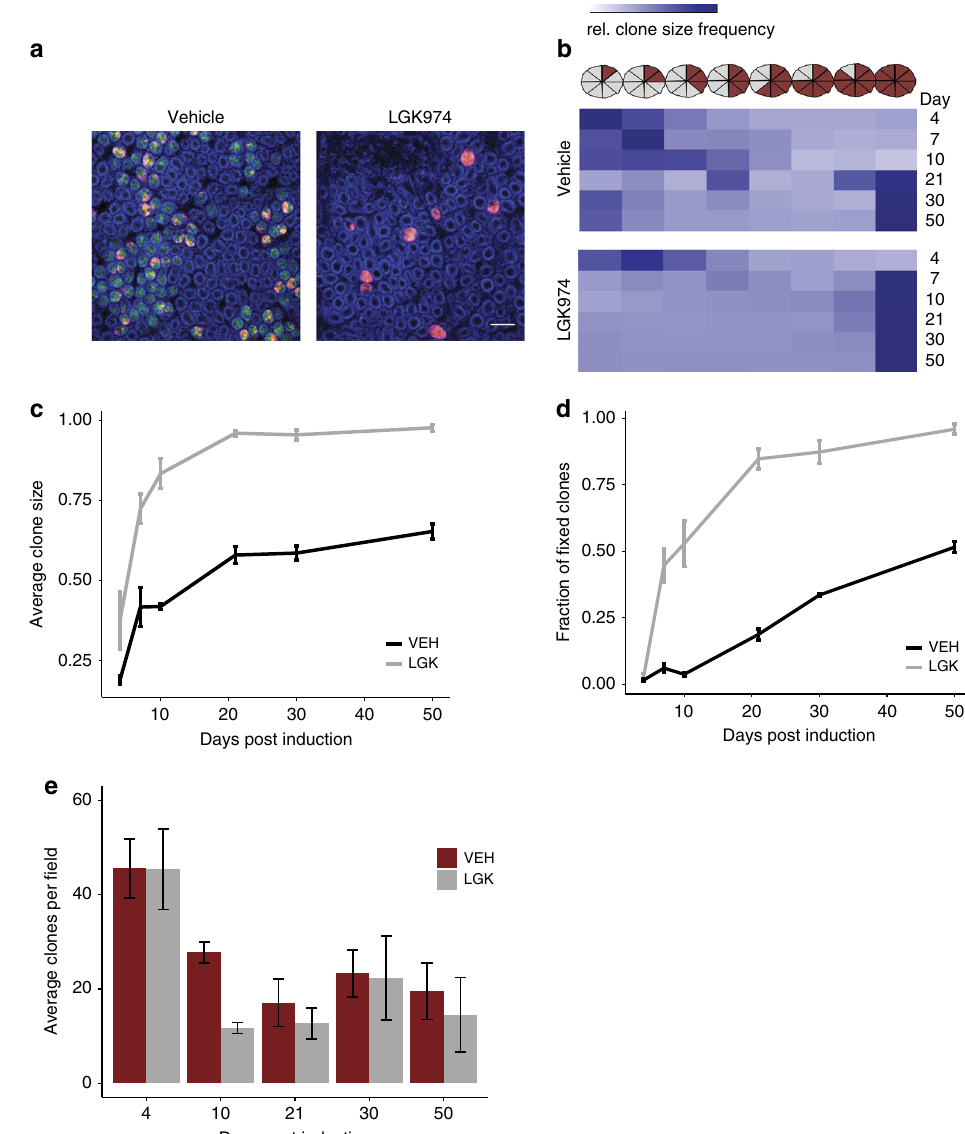
Fig. 2 Stem cell replacement rate is accelerated after LGK974 treatment. Mice were induced with 0.15 mg tamoxifen to induce tdTom fl recombination in few Lgr5-CreER-EGFP + cells. a Mosaic expression of the Lgr5-eGFP (green) and the recombined tdTom fl + cells (red). Nuclei were stained with DAPI (blue). Representative pictures at day 10, note the loss of GFP expression and clones are fully labelled by tdTom + cells in Porcupine inhibitor-treated mice (LGK974). Scale bar = 100 um. b Clone size was counted in 'eighths', at time indicated after induction. At least 200 clones per mouse were counted, vehicle (VEH) N = 3, 3, 4, 4, 3, 3 and LGK974 (LGK) N = 2, 4, 3, 5, 3, 3 for each timepoint, respectively. Heatmap shows all counted clones per timepoint/ group. Note that LGK974 has an increased clone size at day 4 and the mean clone size from day 7 is almost at its maximum. Graph shows the mean clone size ( c ) or the number of fully fi xed crypts ( d ) at different time points as shown in b . Error bars, s.e.m. e Number of tdTom + clones per fi eld. The number of crypts with at least one tdTom + cell were counted per fi eld, ≥ 19 images per mouse, error bars = s.e.m. Note the similar number of clones at day 4 but the greater reduction in clones after LGK974 treatment at day 10. Vehicle (VEH) N = 3, 3, 4, 4, 3, 3 and LGK974 (LGK) N = 2, 4, 3, 5, 3, 3 for each timepoint